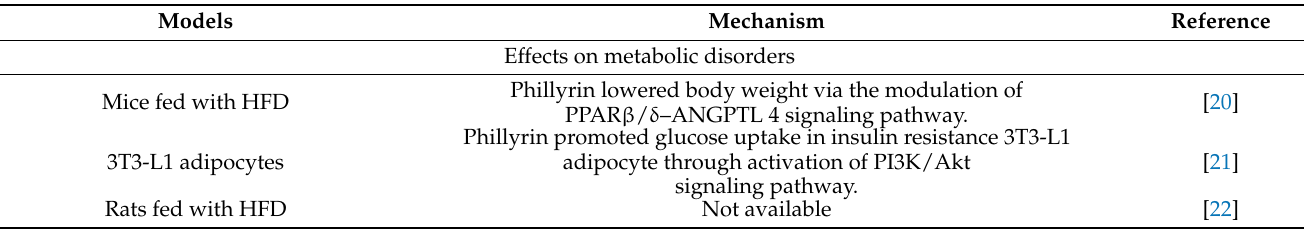
Table 2. Pharmacological properties of phillyrin and possible